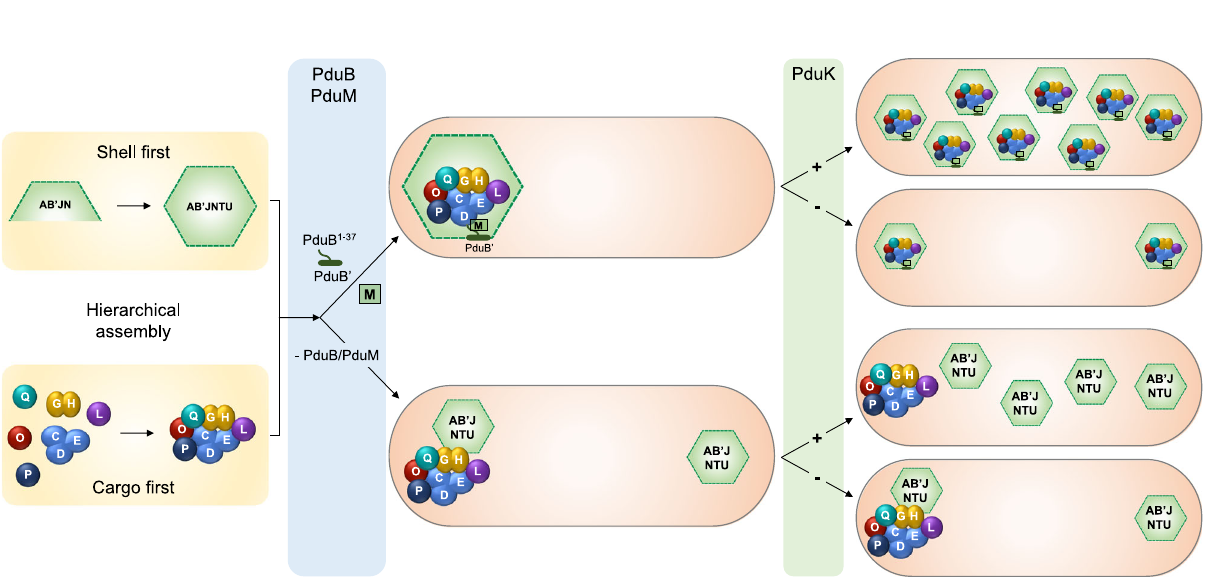
Fig. 7 Model of the Pdu BMC assembly pathway of S . Typhimurium. The Pdu internal enzymes and shell proteins independently self-associate to form cargo and shell aggregates, respectively, at the cell pole. PduB 1 – 37 binds the shell and cargo aggregates, mainly via PduM strongly associates with cargo enzymes. PduK is involved in the relocation of the assembled structural intermediates at the cell pole to other cellular positions, to permit the generation of additional Pdu